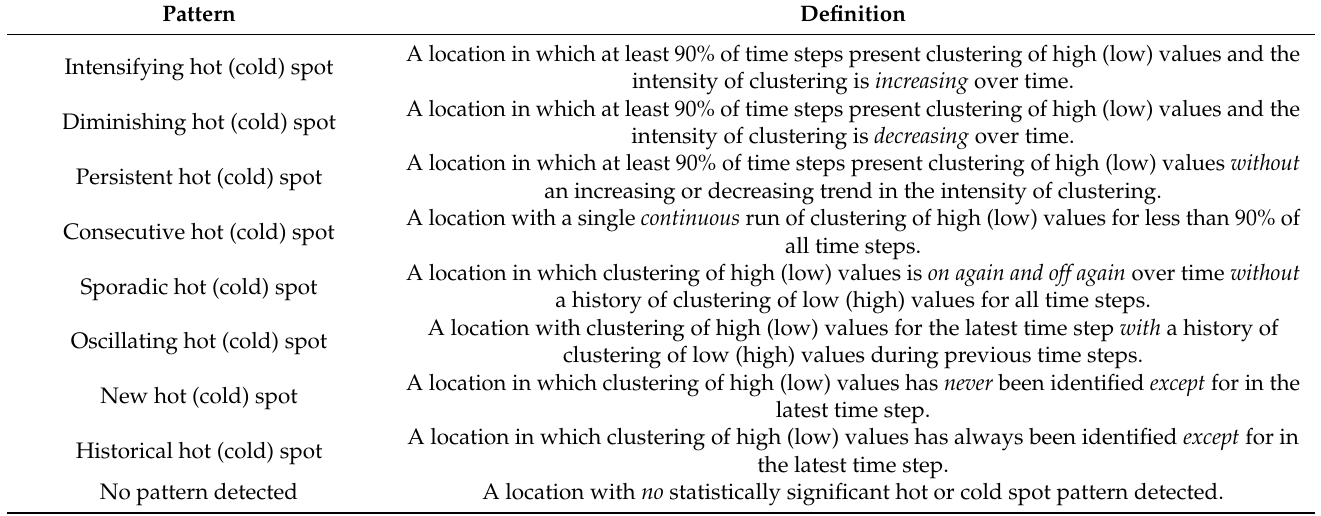
Table 2. Definitions of hot and cold spot trend classifications [24] .